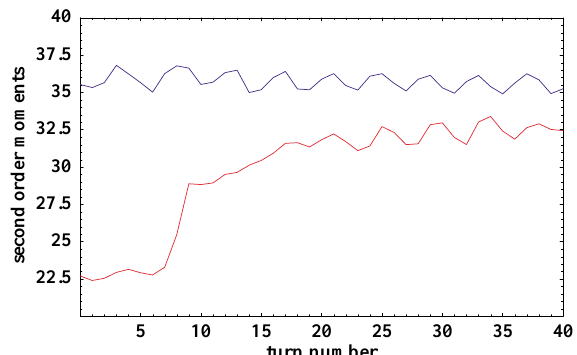
FIG. 23. (Color) Time evolution of second order beam moments (envelopes) with very fast third order lattice resonance (in nor- malized units). Horizontal beam envelope (blue) and vertical beam envelope